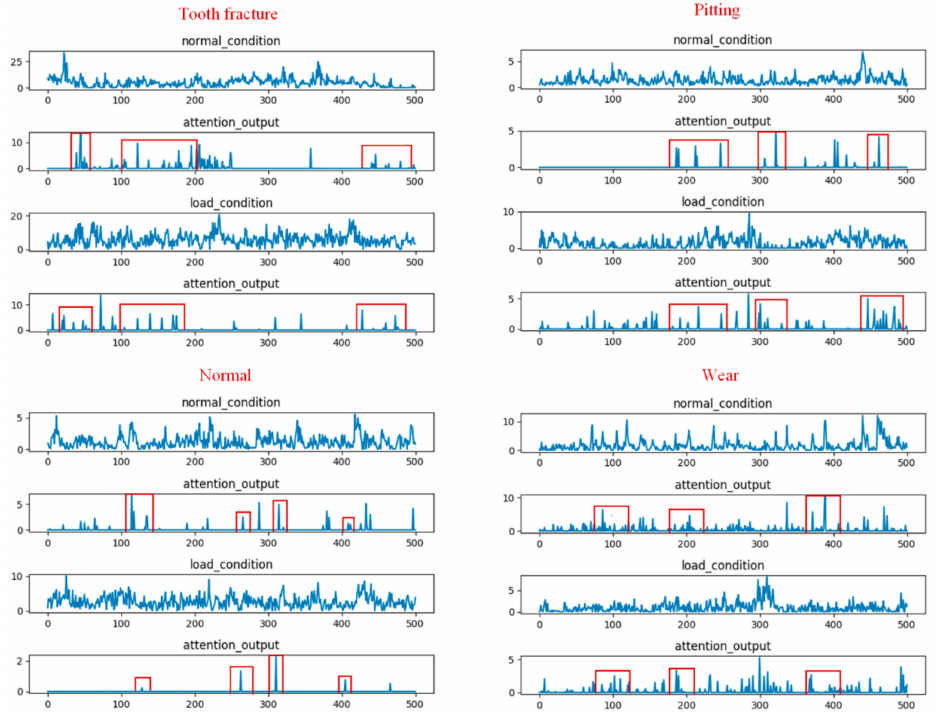
Figure 9. Visualization results of randomly selected filters from the multi-scale pool layer and temporal attention output for four di ff erent types of gear input signals under the two load conditions corresponding to the attention based multi-scale CNN model for evaluation A.